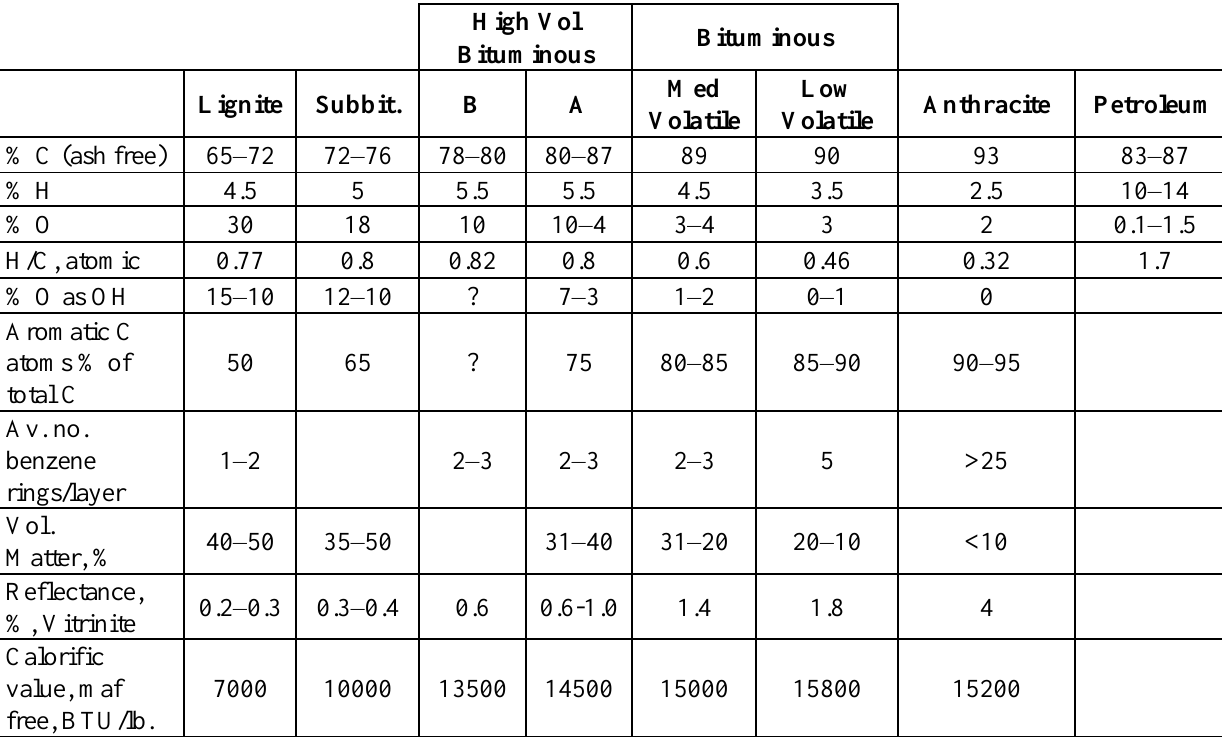
Table 3. Values of coal properties in different rank